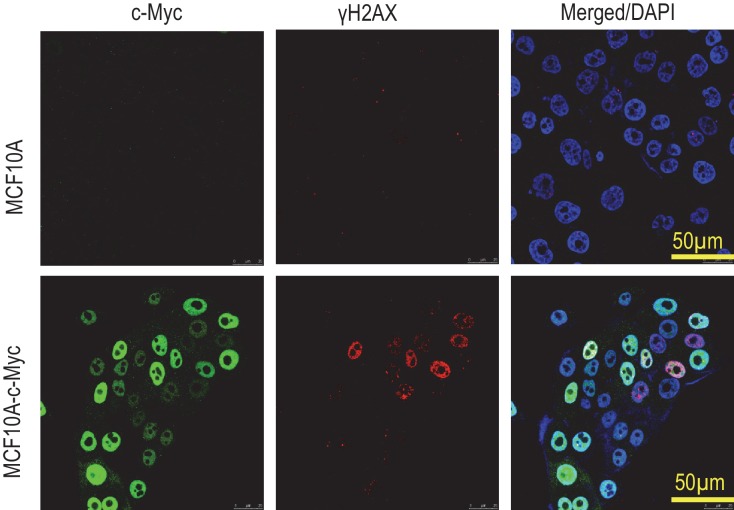
Immunofluorescence co-staining of vector control and Myc-transduced MCF10A cells.Notice the heterogeneous nature of Myc expression.